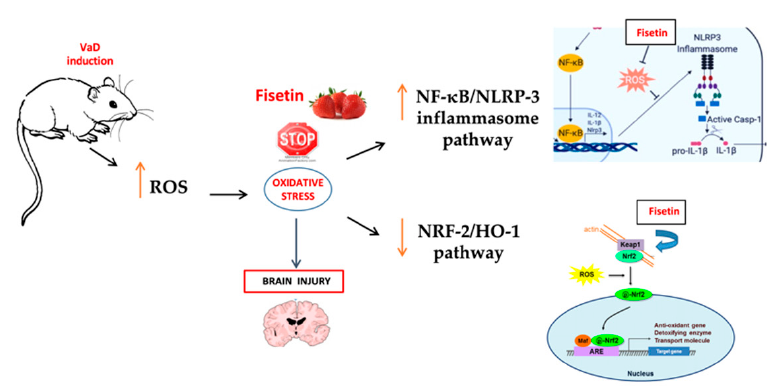
Figure 10. The effect of fisetin on the key molecules and respective signaling